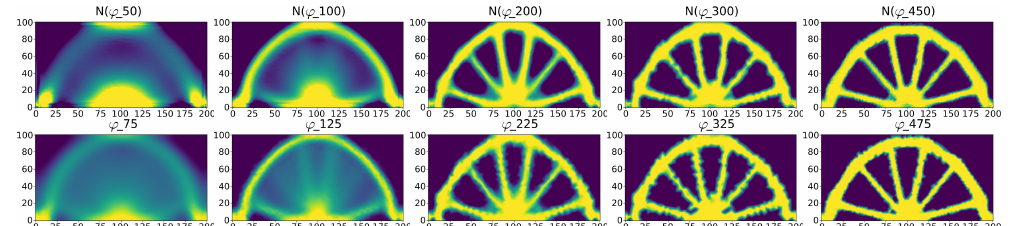
( ϕ n , u ) ( top row ) in comparison with ϕ Figure A5. N 25 n + 1 ; θ CNN